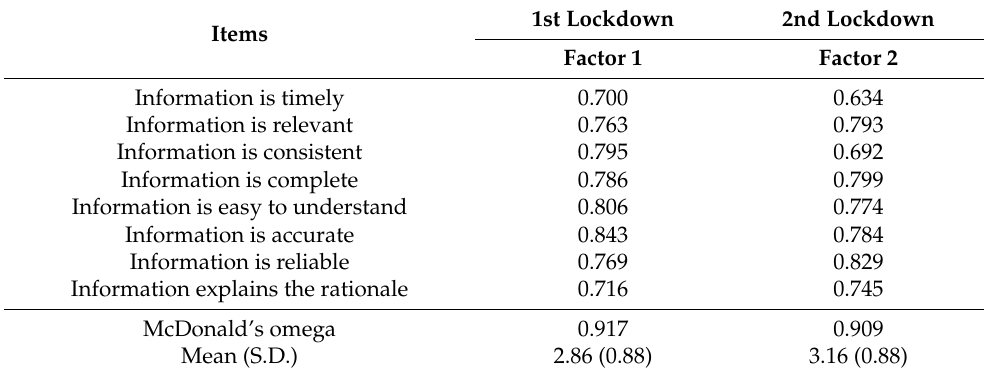
Table 8. Factor loadings from principal component analysis for perceived transparency (study 3; n =